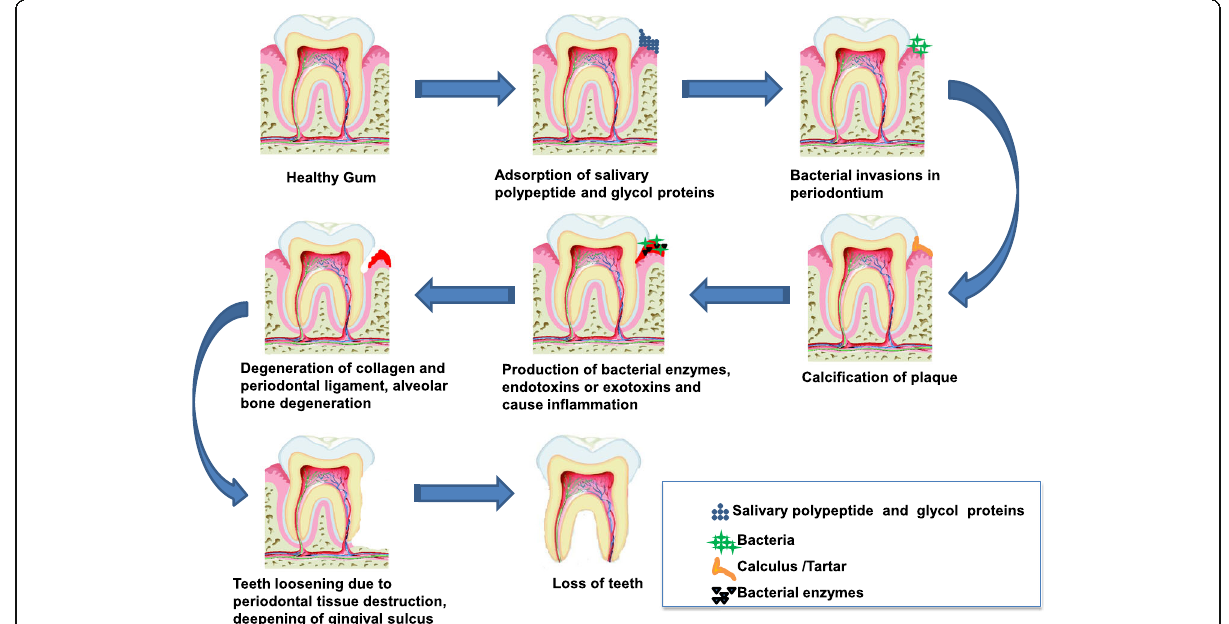
Fig. 2 Mechanism of periodontitis-induced tooth